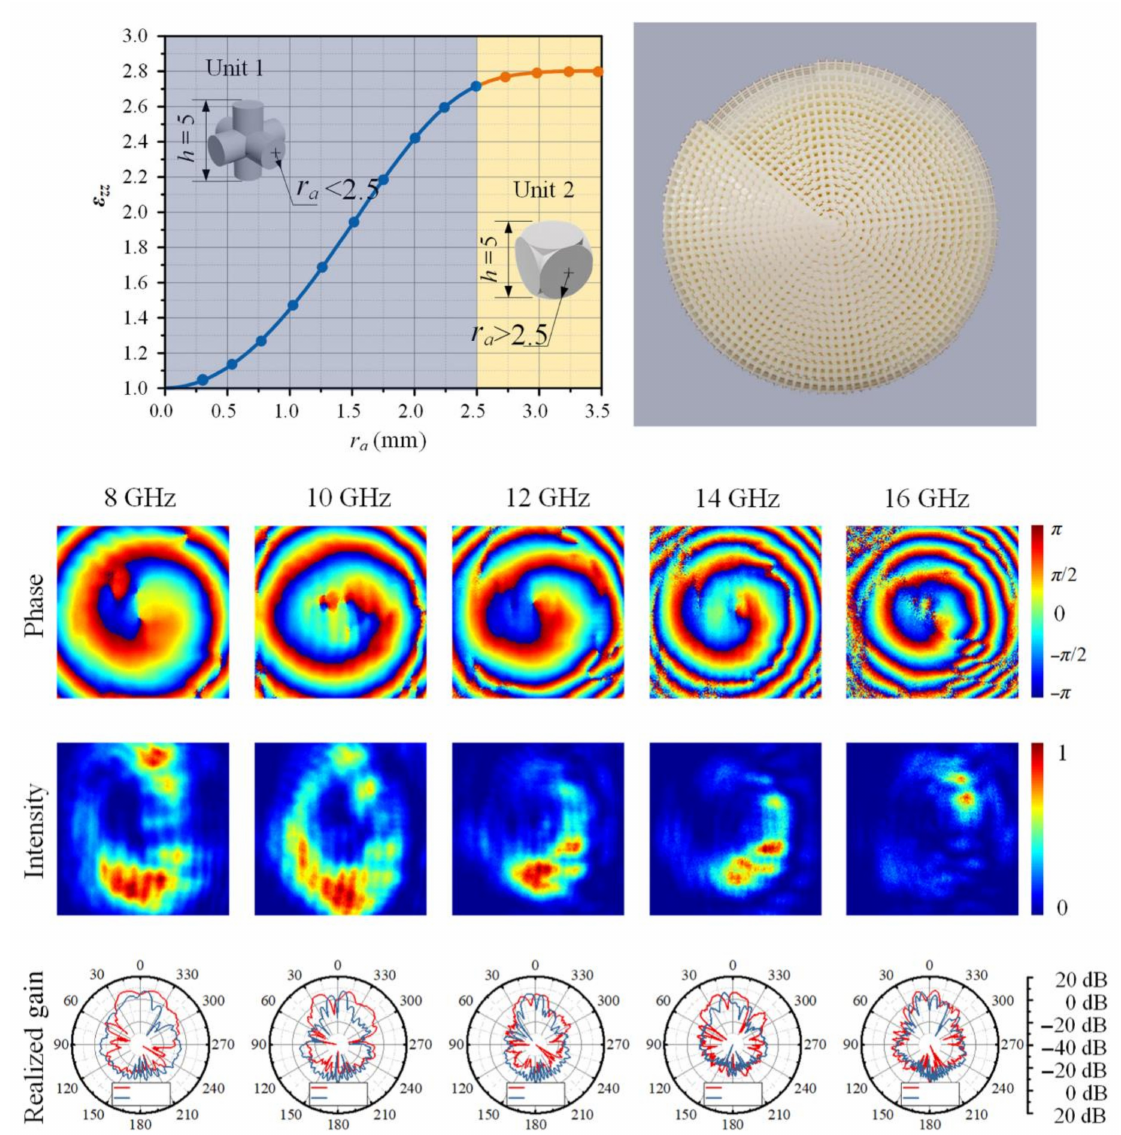
Figure 6. Three dimensional (3D) printed dielectric structure mimicking placed on a flat perfect electrical conductor (PEC) surface mimicking a helicoidal parabolic reflector. The near-field and far-field results show a broadband frequency operation from 8 GHz to 16 GHz, thanks to the use of non-resonant dielectric structures